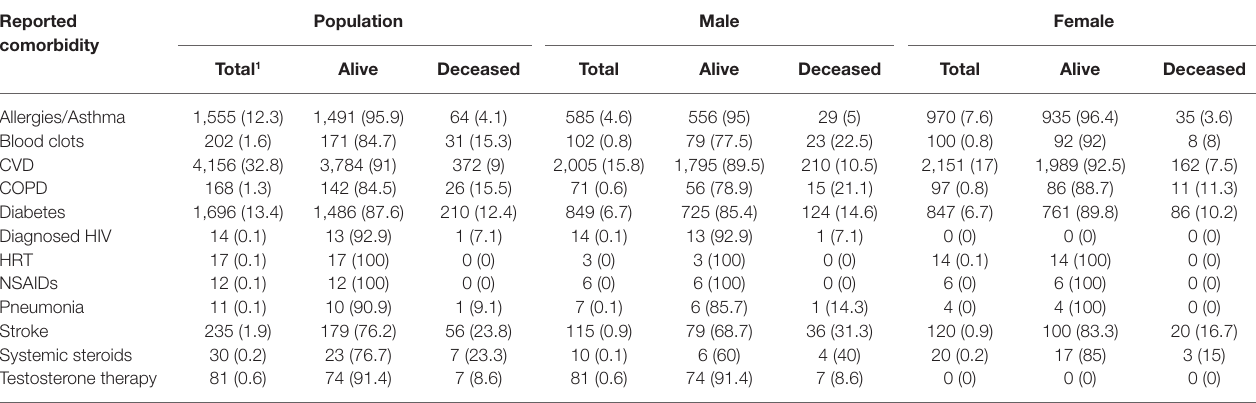
TABLE 2 | Reported comorbidity data.